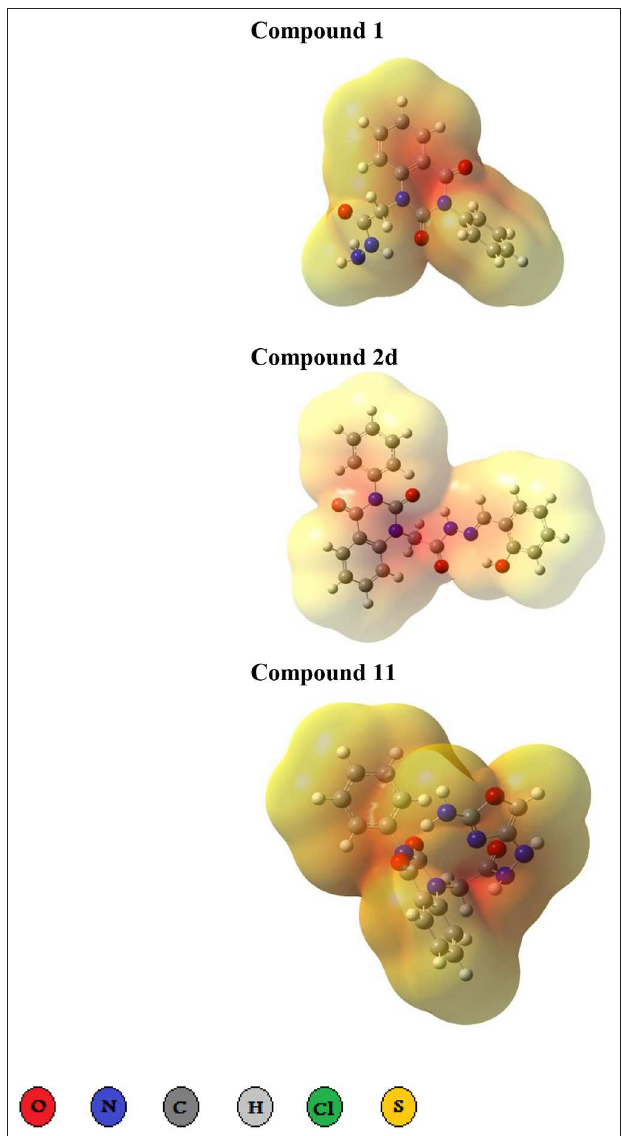
FIGURE 2 | Three dimensional representation of electrostatic potential around the best three docked molecules. Electrostatic potential maps around the best binders 1, 2d, and 11 . The red region represents highly electron density charges (electronegative), while pale yellow represents electropositive part.